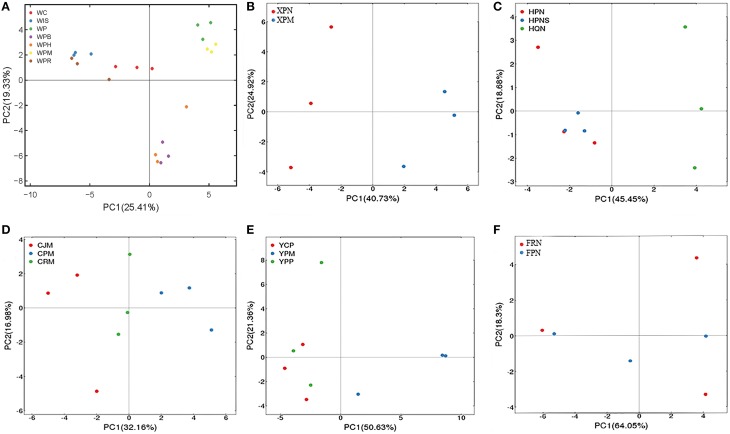
PCA of variations in citrus AMF community from citrus trees of different genotypes. (A) AMF community of four citrus seedlings, i.e., WC (Cirange), WP (Poncirus), WIS (Lime × Orange), and WPR (Poncirus × Red Tangerine), and three scion/rootstock combinations, i.e., WPH (Orange/Poncirus), WPM (Mandarin/Poncirus), WPB (Pummelo/Poncirus) were separated into three groups based on different scion/rootstock genotypes. (B) AMF community of two scion/rootstock combinations (XPN, Newhall/Poncirus; XPM, Mandarin/Poncirus) were separated into two groups based on the different scion genotypes. (C) AMF community of two scion/rootstock combinations (HPN/HPNS: Newhall/Poncirus; HQN: Newhall/Zhique) were separated into two groups based on the rootstock genotypes. (D) AMF community of three scion/rootstock combinations (CJM, Mandarin/Yuzu; CPM, Mandarin/Poncirus; CRM, Mandarin/Red tangerine) were separated into three groups based on different rootstock genotypes. (E) AMF community of three scion/rootstock combinations (YCP, Ponkan/Cirange; YPM, Madarin/Poncirus; YPP, Ponkan/Poncirus) were separated into two groups based on different scion genotypes. (F) AMF communities of the two approach-grafted rootstocks from a single tree (FPN, Newhall sweet orange/Poncirus; FRN, Newhall sweet orange/Red tangerine) could not be grouped based on the different rootstock genotypes.